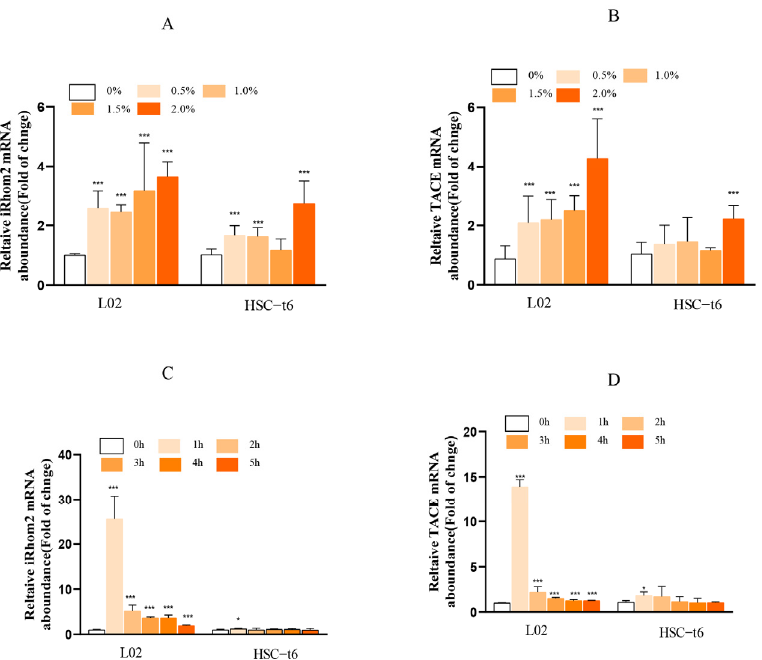
Figure 1. The mRNA expression of iRhom2 and TACE in different cells cultured with alcohol: ( A ) L02; and ( B ) HSC-t6 were treated with alcohol at varying concentrations (0, 0.5, 1.0, 1.5, and 2.0%) for 4 h; ( C ) L02; and ( D ) HSC-t6 were induced with 2.0% alcohol for different time periods (0, 1, 2, 3, 4, and 5 h). The data are expressed as the mean value ± SD ( n = 6). * p < 0.05 and *** p < 0.001 vs. the control group (0% or 0 h group).